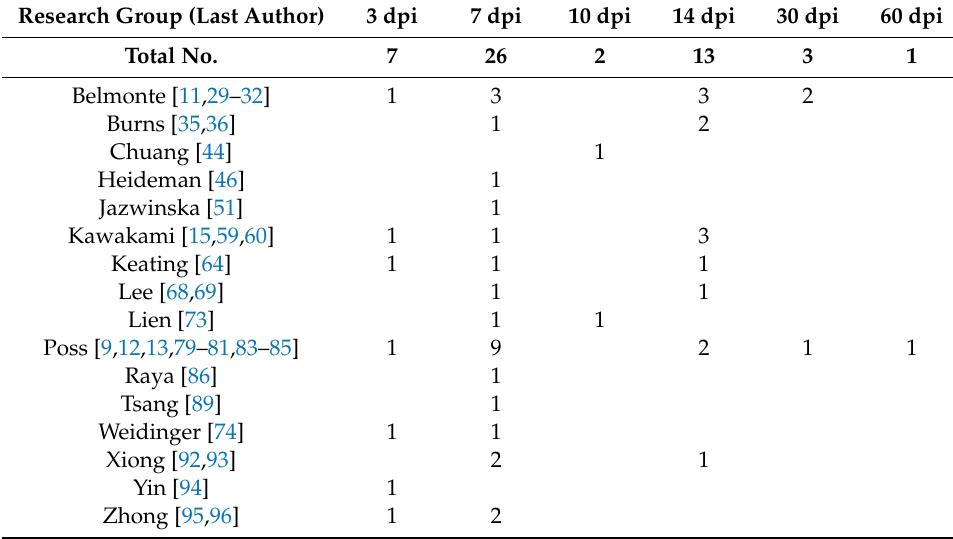
Table 4. Timepoint (days past injury: dpi) used for assessment of cardiomyocyte proliferation after apex resection (AR) in